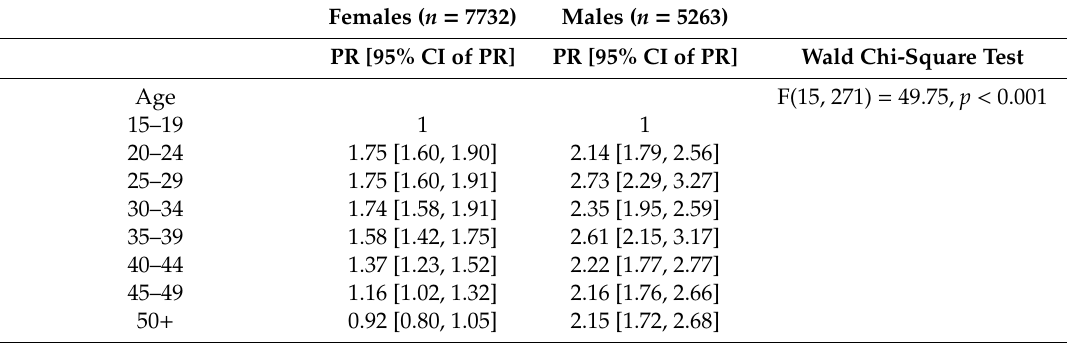
Table 3. Covariates of HIV screening among Mozambicans by gender (male / female). Females ( n = 7732) Males ( n = 5263) PR [95% CI of PR] PR [95% CI of